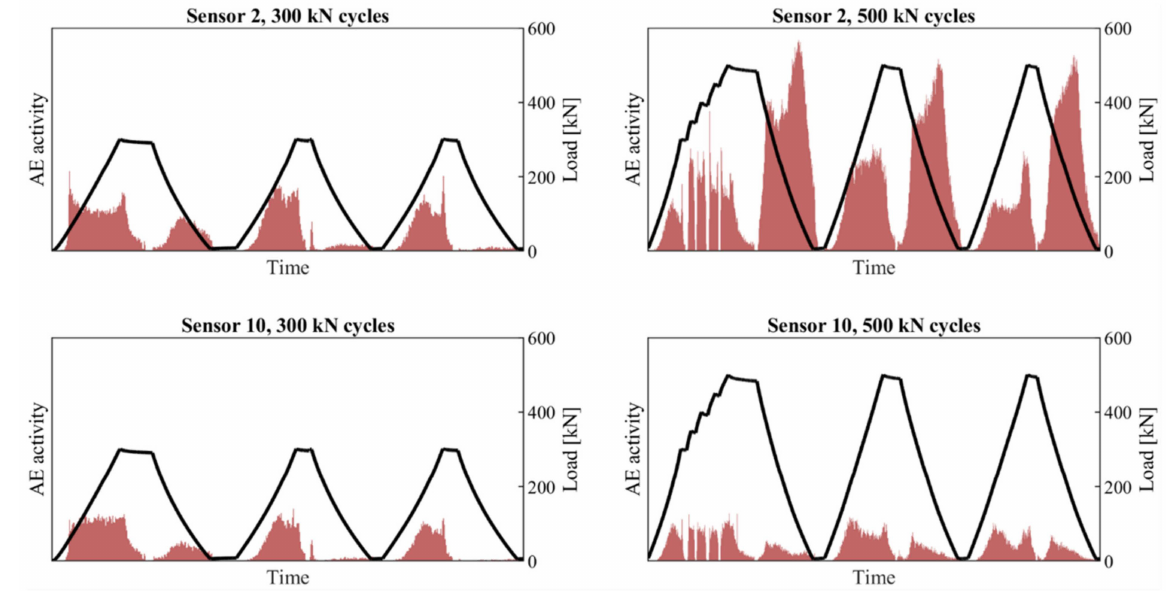
Figure 17. Damage development (activity) near sensor 2 and sensor